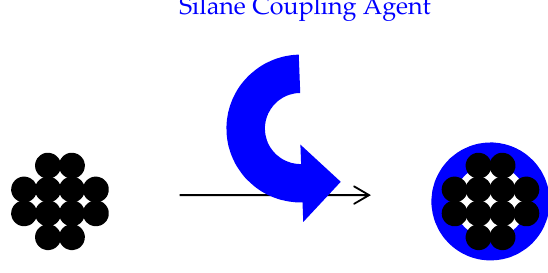
Figure 19. Speculated graphic feature of a coupling agent covered particle cluster.